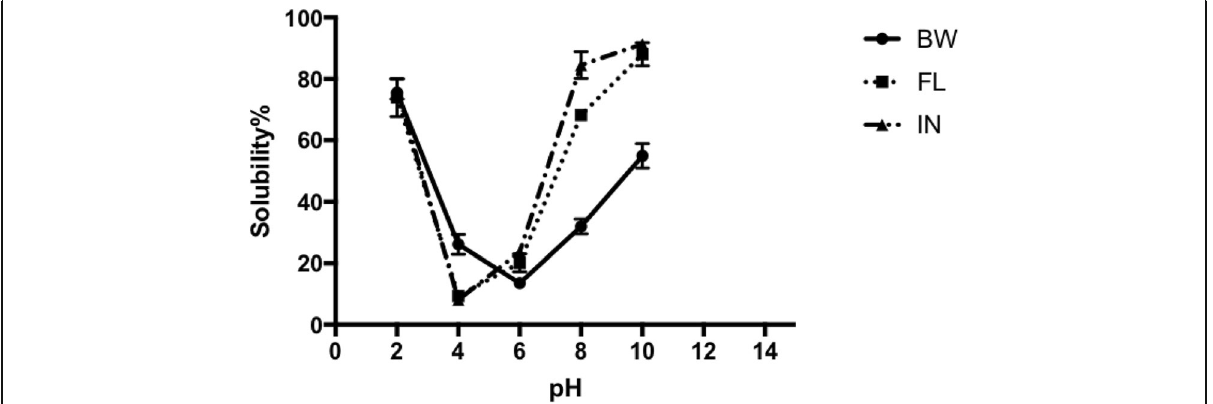
Fig. 9 Solubility of untreated sea cucumber C. frondosa proteins at various pH values BW, Body wall; FL, Flower; and IN, Internal